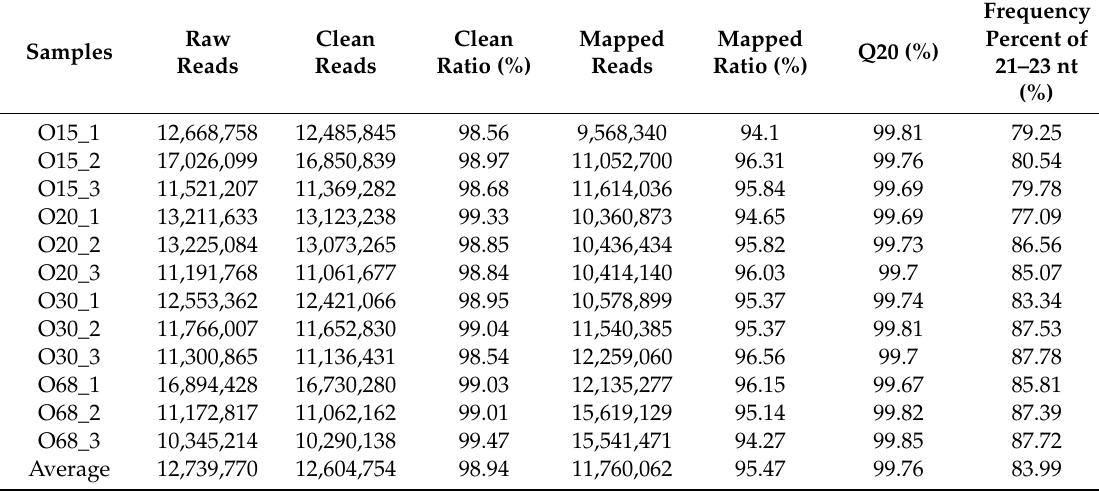
Table 1. Overview of sequencing data for small